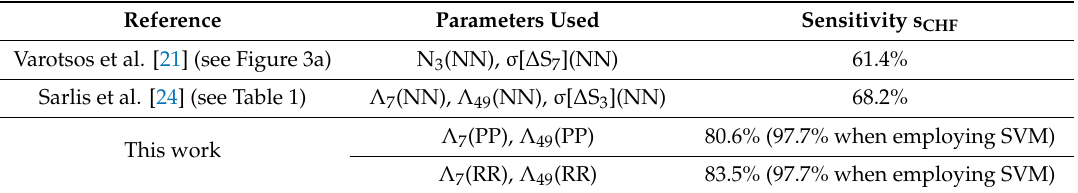
Table 9. Comparison of the previous NTA studies for the distinction of CHF patients from H and SCD individuals with the present NTA study. (In this table: NN refers to NN intervals between consecutive normal beats, while intervals between pairs of normal beats surrounding an ectopic beat are discarded; N 3 is the ratio σ [ ∆ S 3 shuf ] / σ [ ∆ S 3 ], where the superscript shuf denotes that ∆ S 3 shuf time-series is calculated upon randomly shu ffl ing the original NN time-series